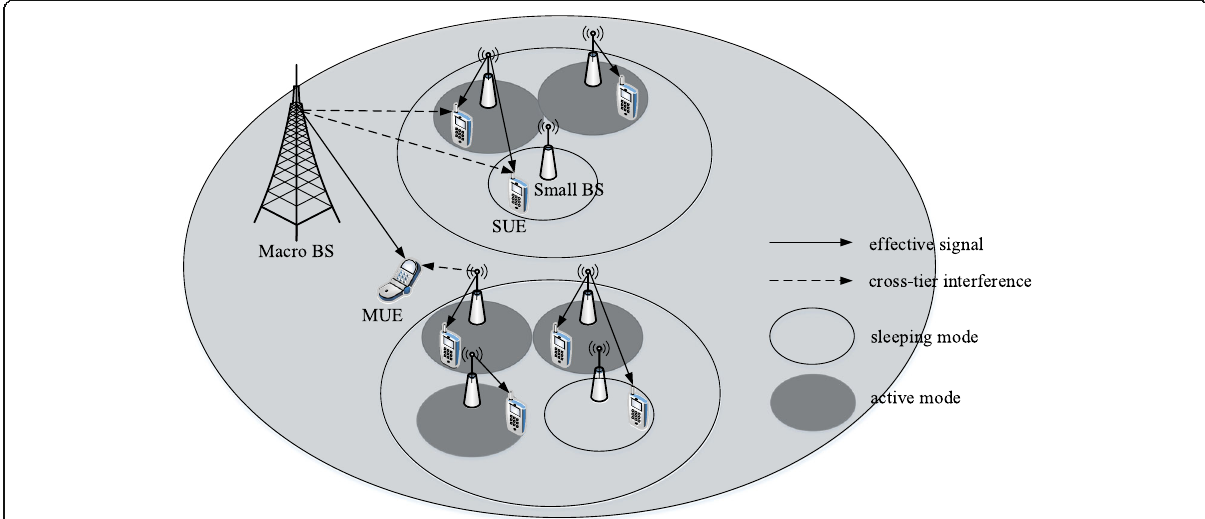
Fig. 1 HetNet system model. We consider a downlink model of HetNet system as shown in Fig. 1. In our model, both of two tiers are considered as cellular network model which consists of radius R m for macro BSs and R s for outdoor small BSs, such as macro cells and pico cells. We define the user equipment which connects to the macro BS and small BS as MUE and SUE, respectively. We assume that the UEs are uniformly distributed in the network, and each UE will associate with a macro BS or a small